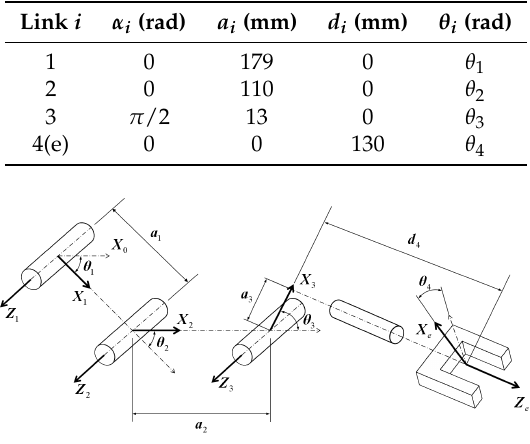
Figure 2. Coordinate frames of the proposed